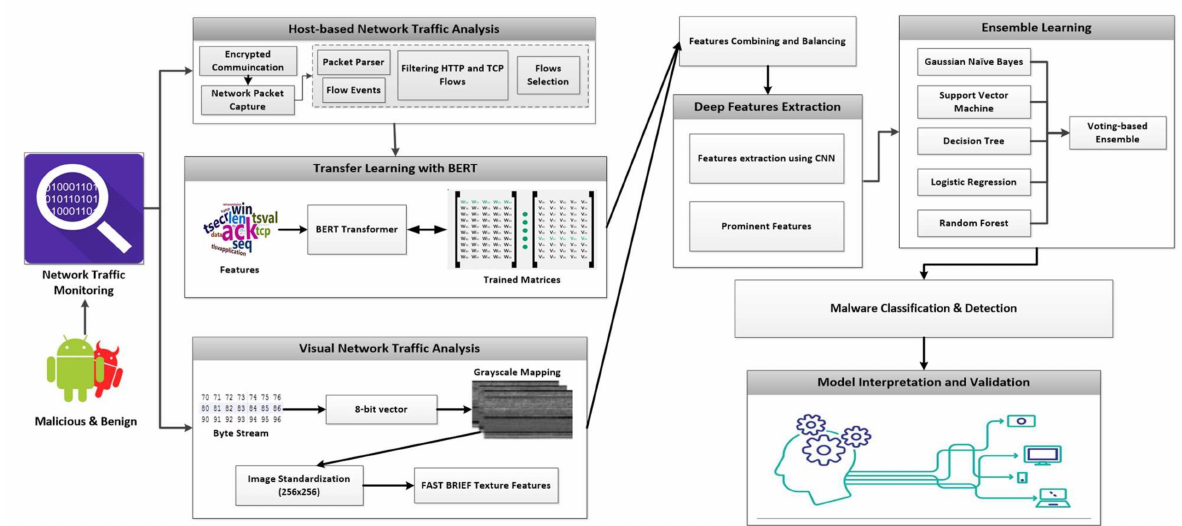
Figure 2. Explainable malware detection system using transformer-based transfer learning and visual